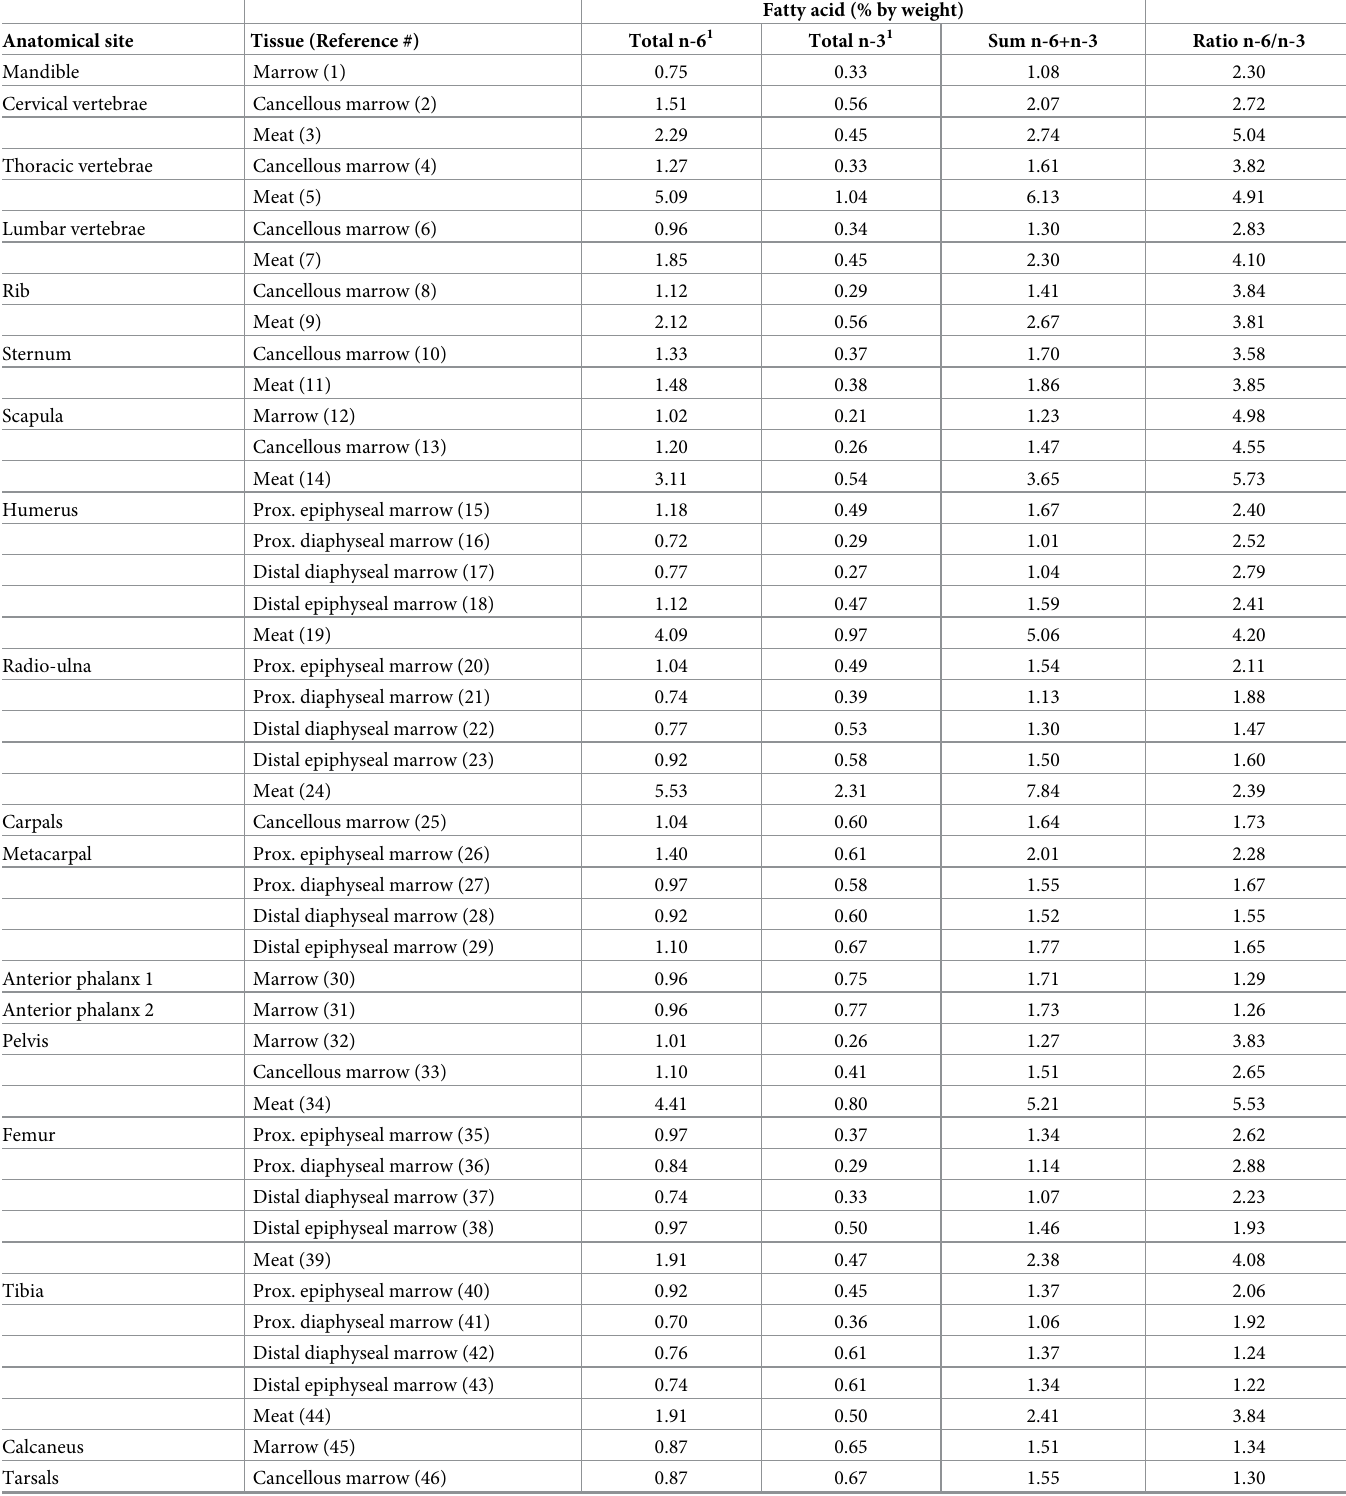
Fatty acid (% by weight)